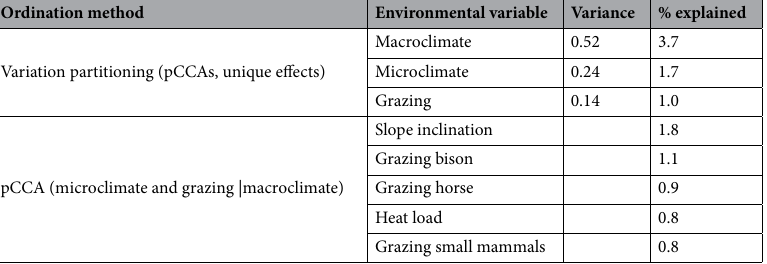
Table 3. Constrained ordinations of overall data set. a) Variation partitioning (total inertia: 14.2, total % explained: 10.5%); b) pCCA of microclimate and grazing after removing the effects of macroclimate (total inertia: 12.9, total explained: 5.5%; Eigenvalues: axis 1 = 0.29, axis 2 = 0.16; % explained: axis 1 = 2.3, axis 2 = 1.2). Only significant variables